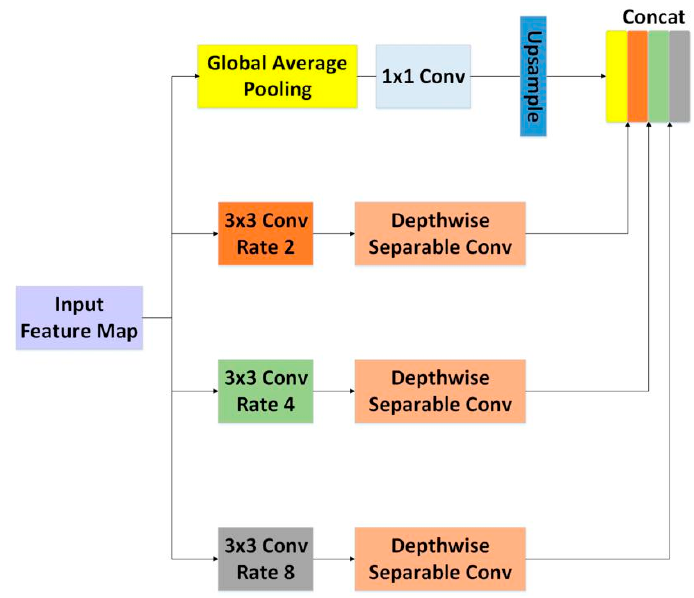
Figure 6. The Atrous Spatial Pyramid Pooling (ASPP) module we used.